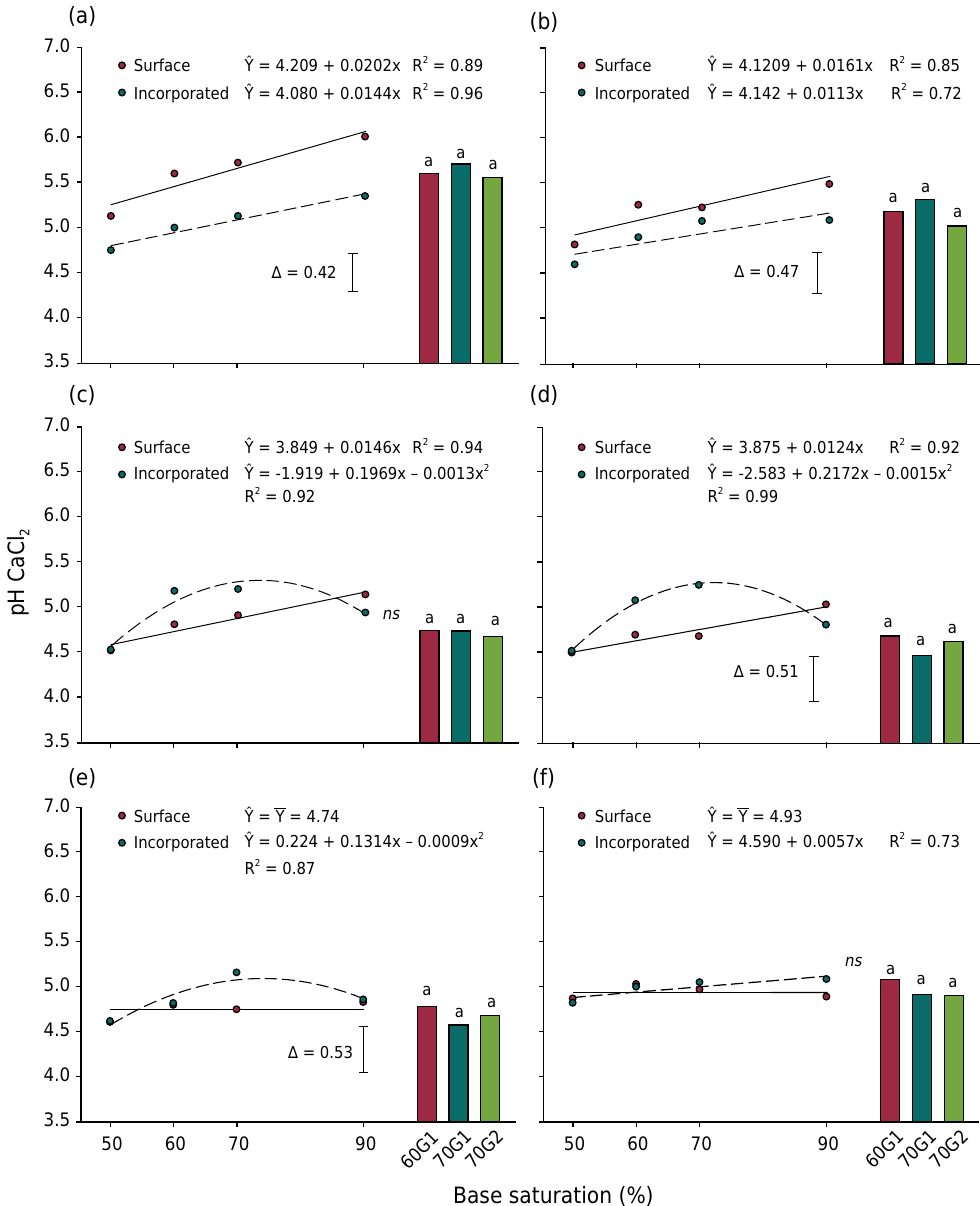
Figure 1. Soil pH(CaCl 2 ) in the 0.00-0.05 (a), 0.05-0.10 (b), 0.10-0.20 (c), 0.20-0.30 (d), 0.30-0.40 (e), and 0.40-0.60 m (f) layers 48 months after treatment. Soils were limed to different base saturation (BS) levels (50, 60, 70, and 90 %) by surface application (SL) or lime incorporation (IL) or treated by surface application of lime (60 and 70 % BS) and a standard (G1) or double (G2) dose of phosphogypsum as 60G1, 70G1, and 70G2. Different letters above columns indicate significant differences between phosphogypsum treatments (Tukey’s test, p<0.05). Vertical bars represent least significant differences between treatments (Dunnett’s test,